Question: Author a descriptive caption for the visualization shown.
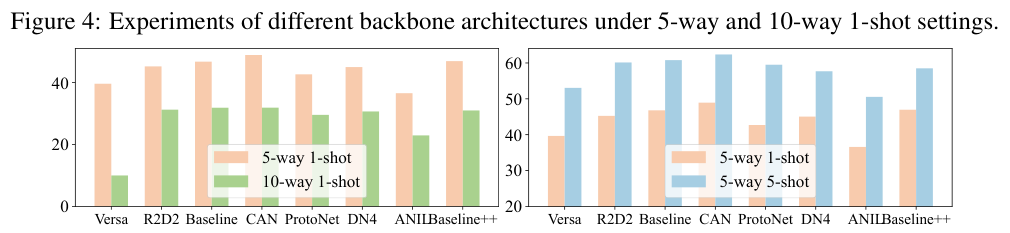
Answer: Experimental results of different ways (left) and shots (right) on testing performance.